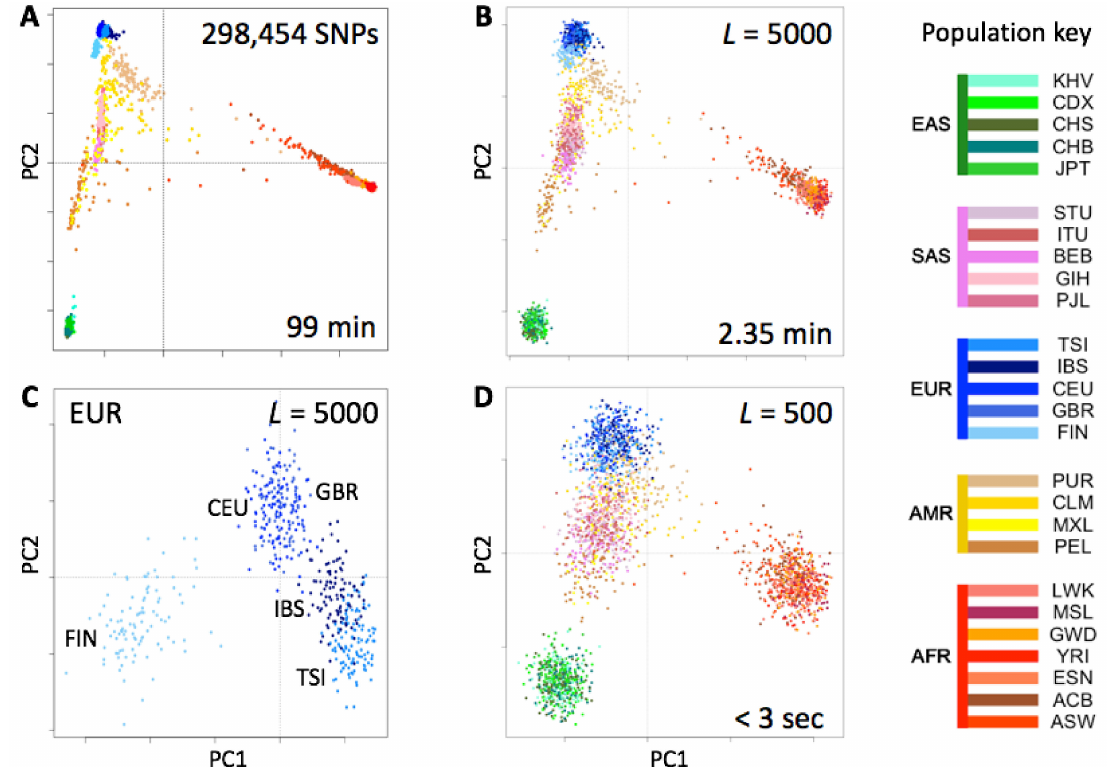
Figure 3. Estimates of population structure in the 1000 Genomes Project data set at different resolutions. Individuals are color coded according to their population as per the key to the right. EAS, SAS, EUR, AMR and AFR: East Asian, South Asian, European, Admixed American, and African, respectively. ( A ) Principal components analysis (PCA) of the 2504 individuals using ~300,000 SNPs. ( B ) PCA on genotype fingerprints (N = 2504) with L = 5000. ( C ) PCA on genotype fingerprints of European populations (N = 503) with L = 5000. ( D ) PCA on genotype fingerprints (N = 2504) with L =